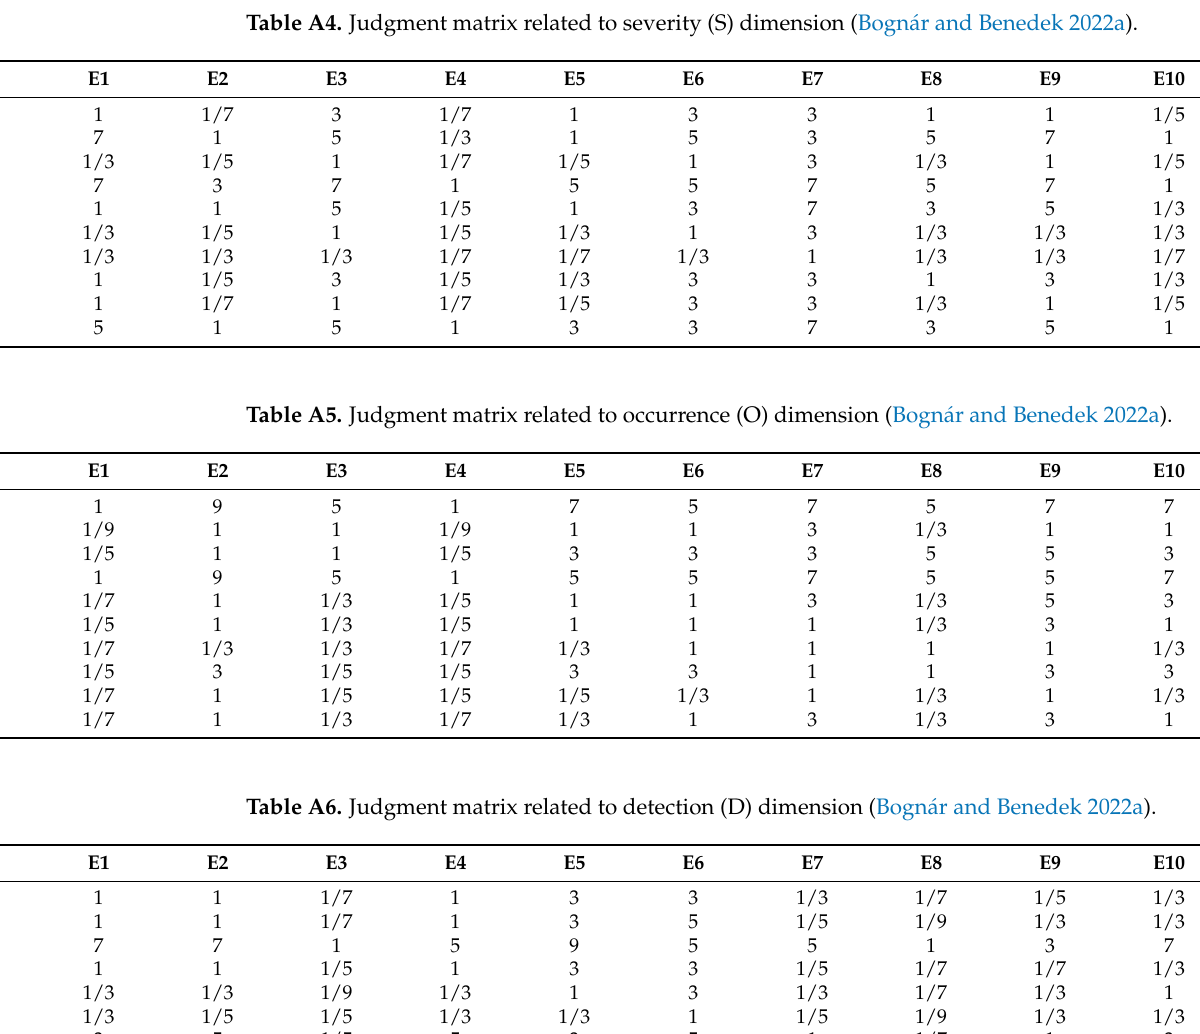
Table A4. Judgment matrix related to severity (S) dimension (Bogn á r and Benedek 2022a).